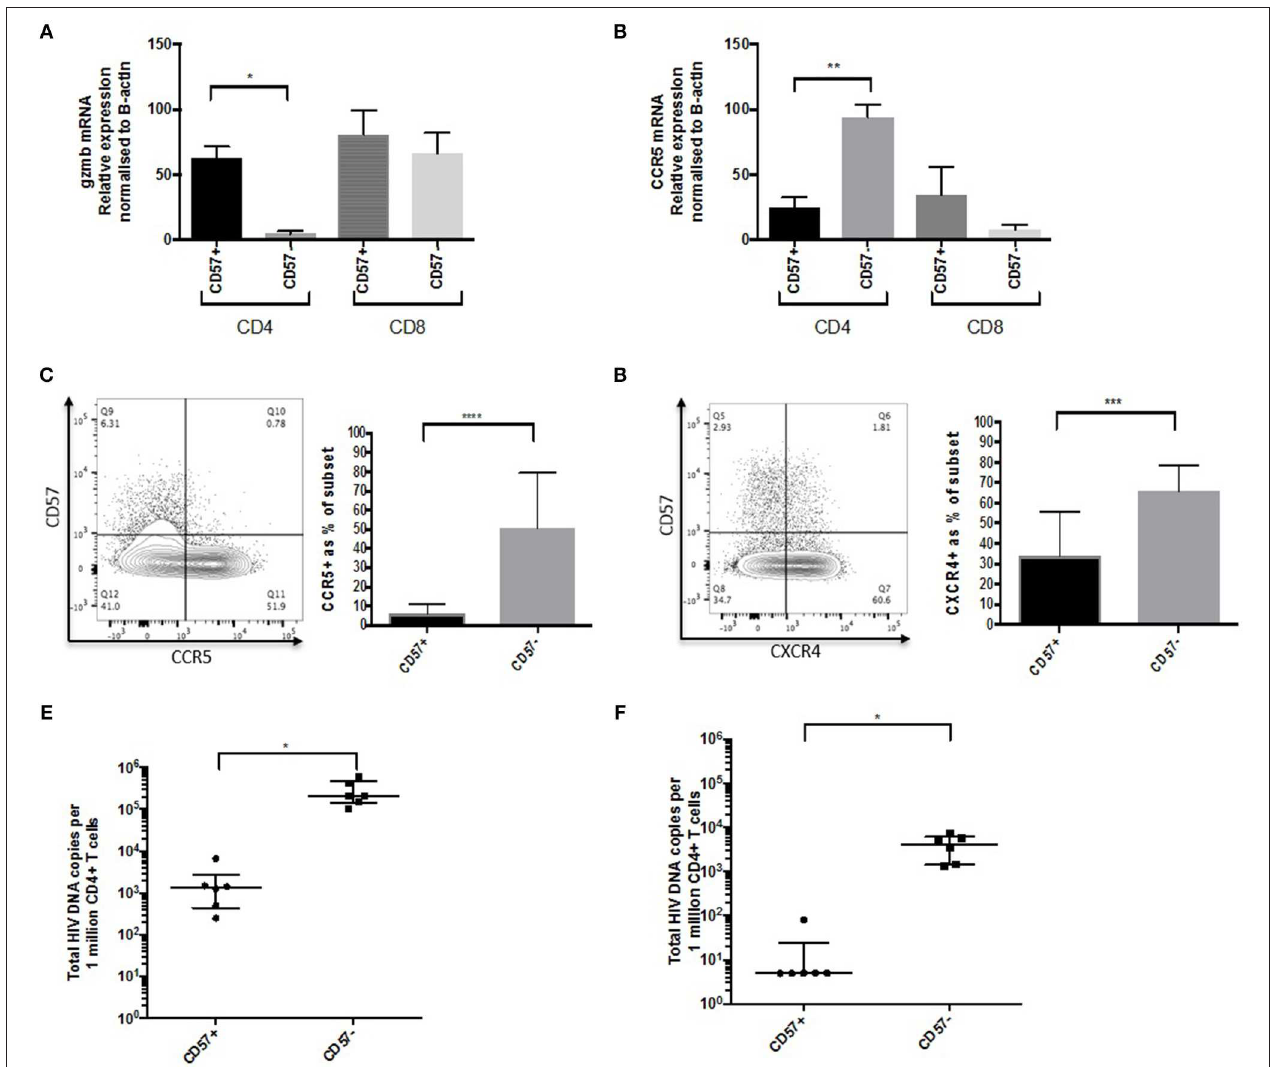
FIGURE 6 | CD57 + CD4 CTLs are not a component of the HIV reservoir. (A) GzmB mRNA levels in CD57 + and CD57 − in CD4 and CD8 subsets. (B) ccr5 mRNA levels in CD57 + and CD57 − in CD4 and CD8 subsets. (C) CCR5 protein in CD57 + and CD57 − in CD4 + in untreated PHI. (D) CXCR4 protein in CD57 + and CD57 − in CD4 + in untreated PHI ( n = 12). (E) Total HIV DNA untreated PHI. (F) Total HIV DNA PHI 1-year post-ART. * p < 0.05, ** p < 0.01, *** p < 0.001, **** p <